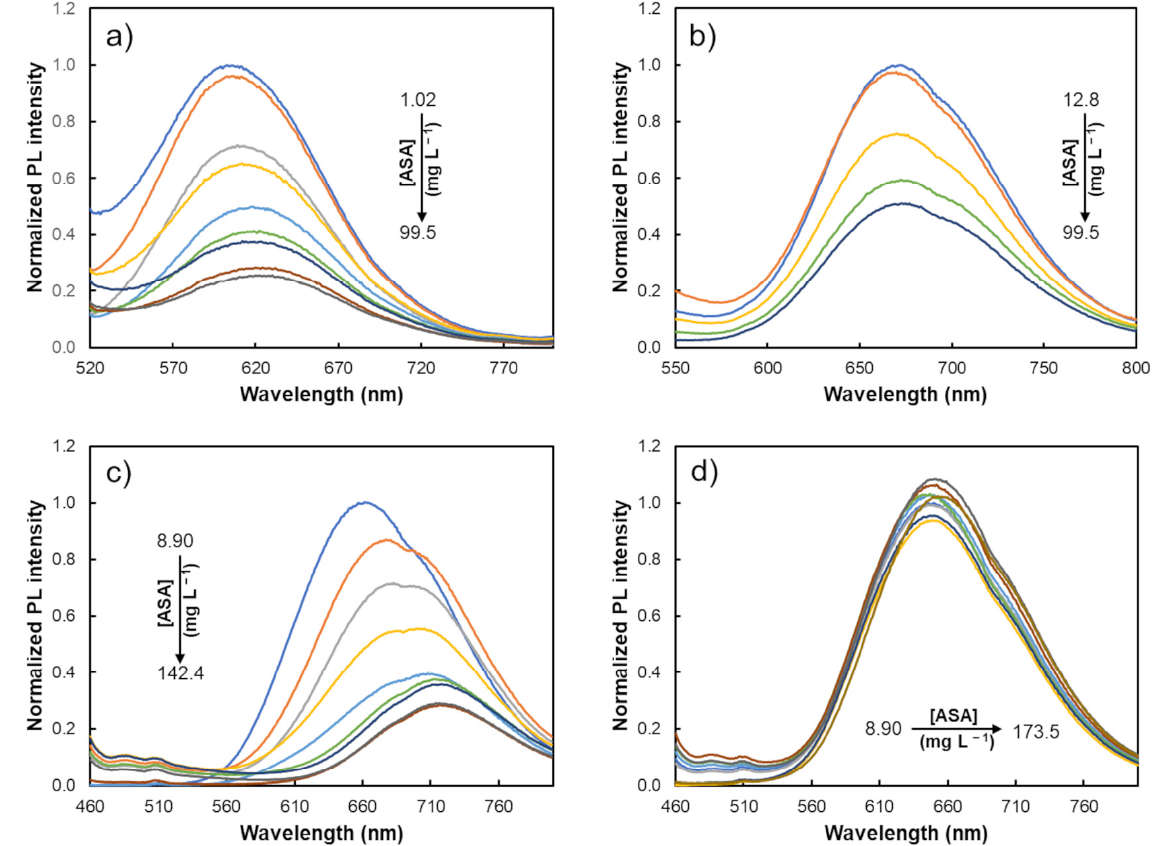
Figure 3. Normalized photoluminescence spectra of ( a ) D-Pen AIS/ZnS in the absence and presence of increasing concentrations of ASA ranging from 1.02 to 99.5 mg L − 1 ; ( b ) TMA-AIS alone and by adding increasing ASA concentrations between 12.8 and 99.5 mg L − 1 ; ( c ) MPA-AIS before and after the interaction process with ASA at a concentration level from 8.90 to 142.4 mg L − 1 and ( d ) TMA- AIS/ZnS alone and upon interacting with increasing concentrations of ASA (8.90–173.5 mg L − 1 ).